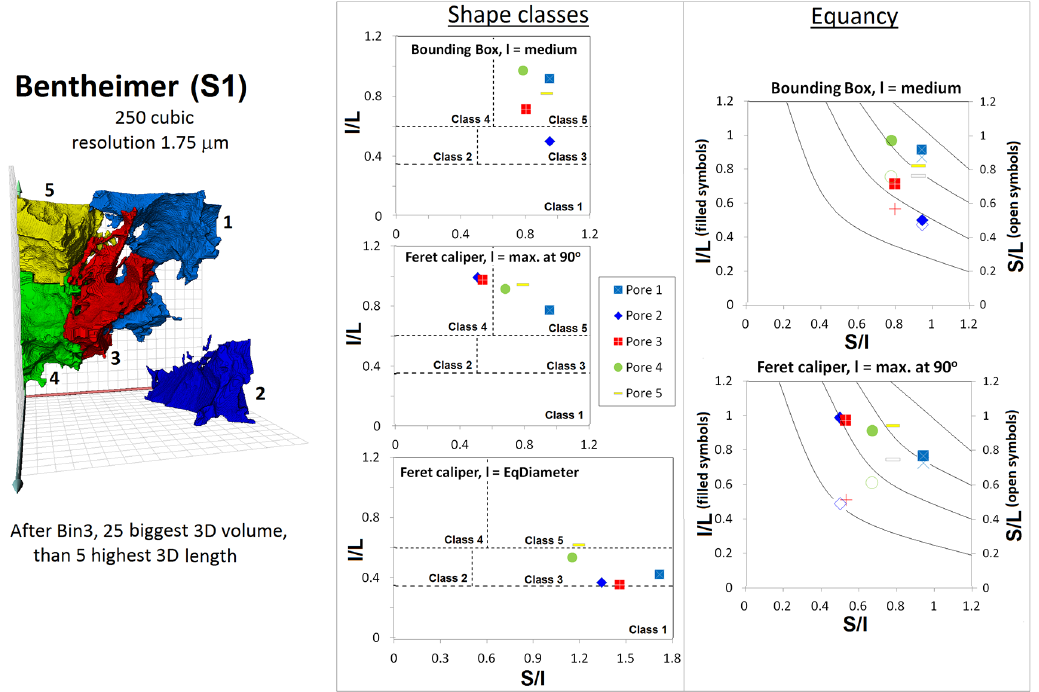
Figure 7. Pore shape results (S 1 ) for equancy and shape classes based on distinct descriptors for the five categorized pores in a 250 3 voxel volume. The lines shown in the graphics delimitate distinct particles shapes, as described in Fig. 2.